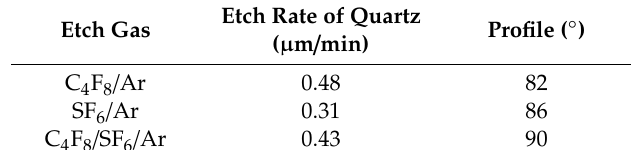
Table 4. The results of quartz etching with three chemical gases.